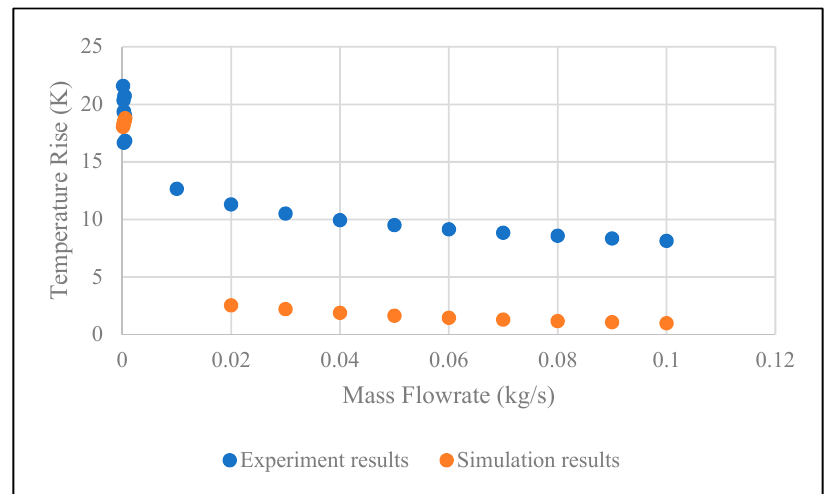
Figure 6. Comparison between the theoretical and experimental results on the effect of air mass flow rate to the temperature at G = 800–900 Wm − 2 and T a , avg = 310